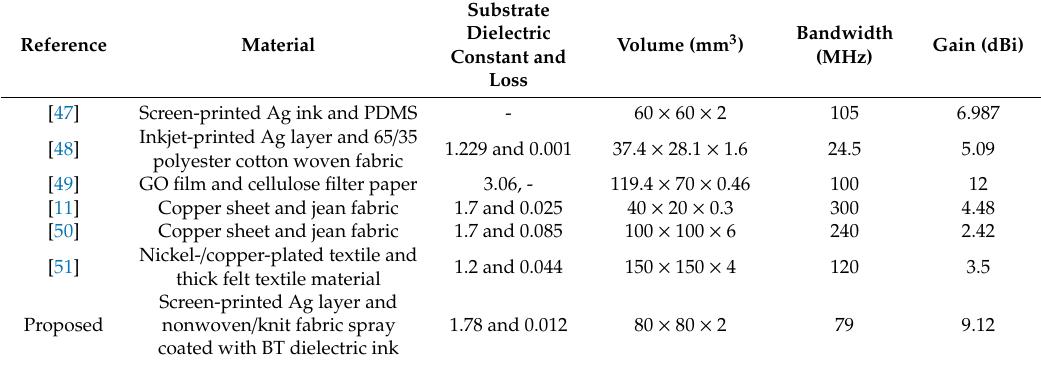
Table 3. Comparison of the antennas proposed in previous works.